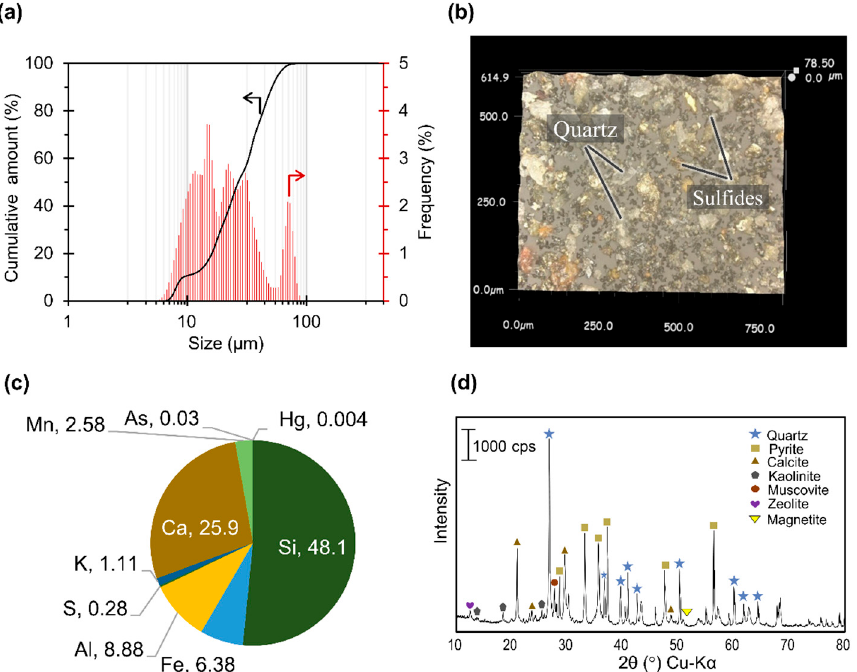
Figure 2. ( a ) Particle size distribution, ( b ) photomicrograph, ( c ) chemical composition and ( d ) XRD pattern of the ASGM tailings sample used in this study.